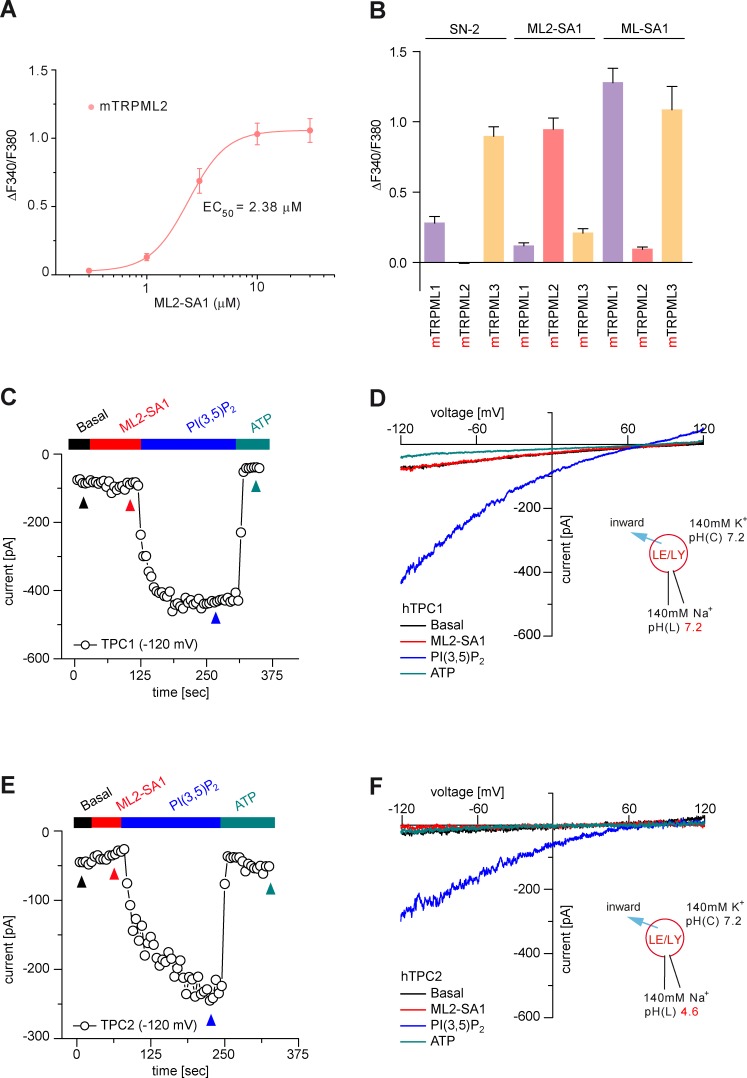
DRC of ML2-SA1 effect on mTRPML2, effects of ML2-SA1, SN2, and ML-SA1 on mTRPML channel isoforms, and cytotoxicity of ML2-SA1.(A) Dose-response curve (DRC) for ML2-SA1 effect on mouse TRPML2 in HEK293 cells, obtained from fura-2 calcium imaging experiments. The calculated EC50 value for mTRPML2 is: 2.38 ± 0.001 μM (mean ± SEM). (B) Summary of fura-2 calcium imaging results showing the effect of SN-2, ML2-SA1, and ML-SA1 (10 μM, each) on mouse TRPML1, 2, and 3. (C, E) Representative time courses of continuous recordings using a ramp protocol (−120 mV to +120 mV in 500 ms, every 5 s, holding potential = 0 mV). Data obtained at +120 mV were plotted against time. Recordings at the time points as indicated were used for the IV relationships (D, F), respectively. No significant ML2-SA1 (10 μM) elicited current was detectable in vacuolin-enlarged endolysosomes isolated from hTPC1 (C–D) or hTPC2 (E–F) expressing HEK293 cells. PI(3,5)P2 (1 μM, batch solution) was applied as positive control to elicited TPC currents. ATP (1 mM, bath solution) was applied to inhibit PI(3,5)P2-evoked TPC currents.